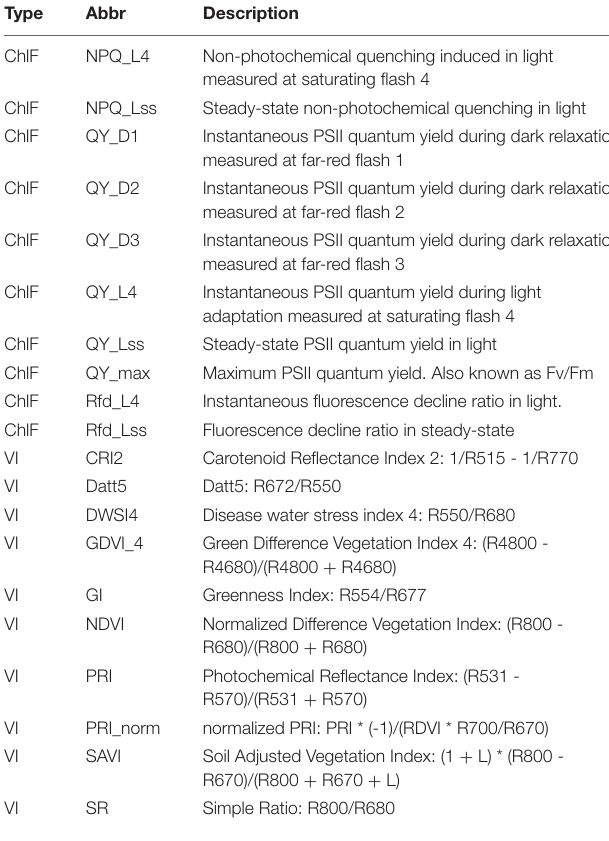
TABLE 3 | Description of top ten kinetic chlorophyll fluorescence (ChlF) parameters selected by Random Forest and top ten vegetation indices (VI) selected by Neural Network